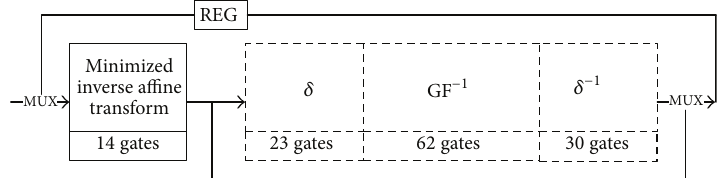
Figure 14: An alternative setup which utilizes registers to store temporary